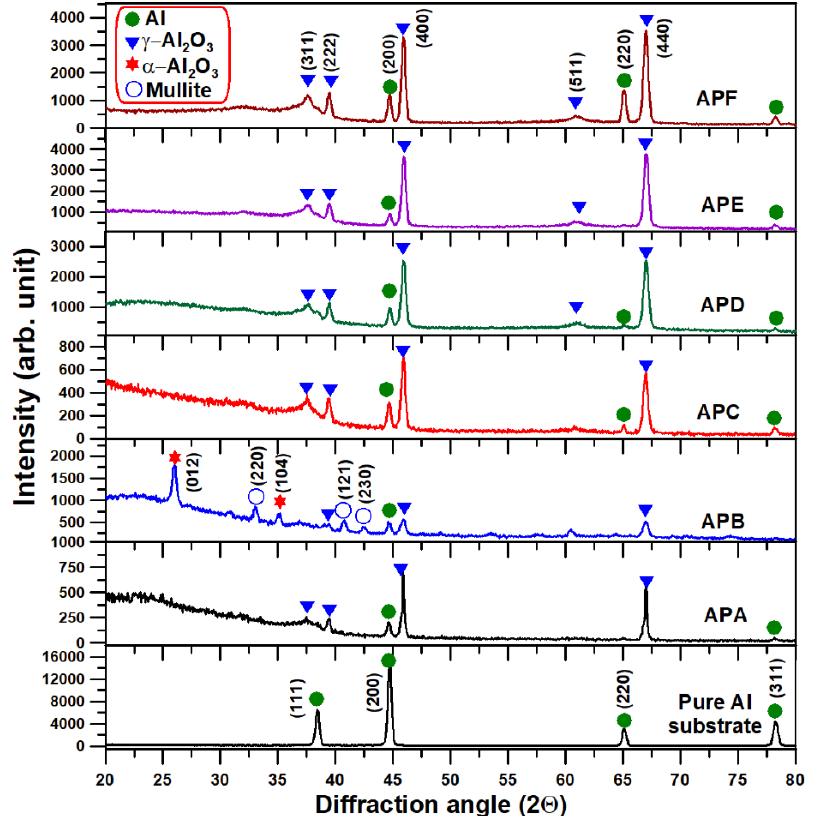
Figure 4. X-ray di ff raction patterns of pure aluminum without PEO coating and PEO coatings with two Figure 4. X-ray diffraction patterns of pure aluminum without PEO coating and PEO coatings with di ff erent alkaline electrolytes with di ff erent Si 3 N 4 nanoparticle addition concentrations and di ff erent two different alkaline electrolytes with different Si 3 N 4 nanoparticle addition concentrations and duty cycles at a fixed different duty cycles at a fixed frequency.